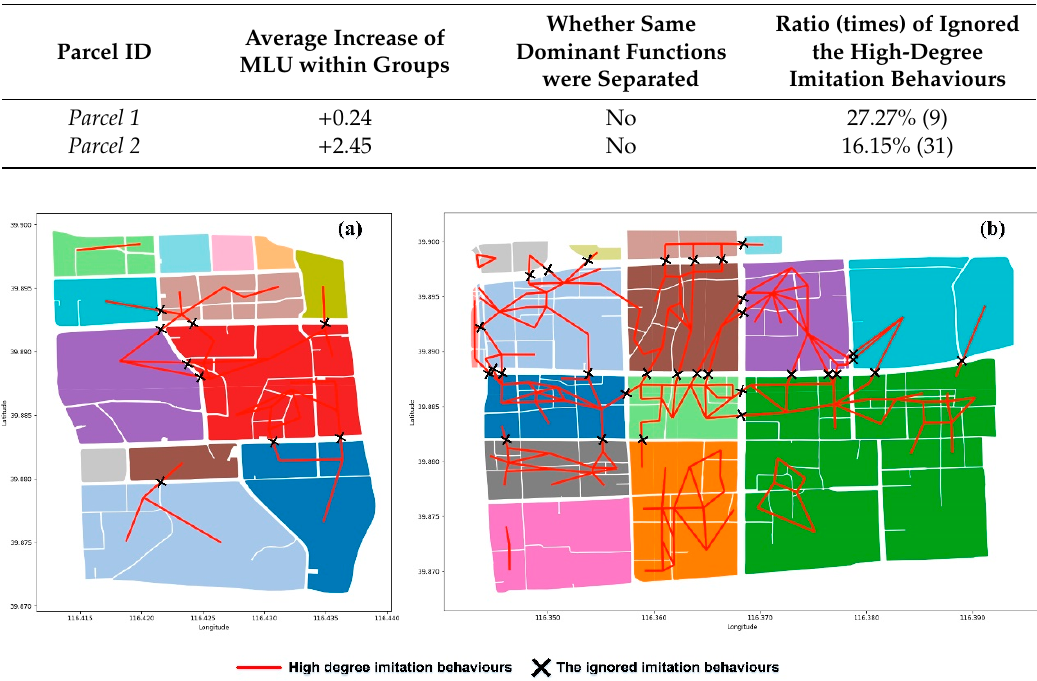
Figure 18. The ignored imitation behaviours among parcel group: ( a ) grouping result of Parcel 1 and ( b ) grouping result of Parcel 2 . Table 5. Analysis of parcel grouping results based on infiltration behaviours (UPG).